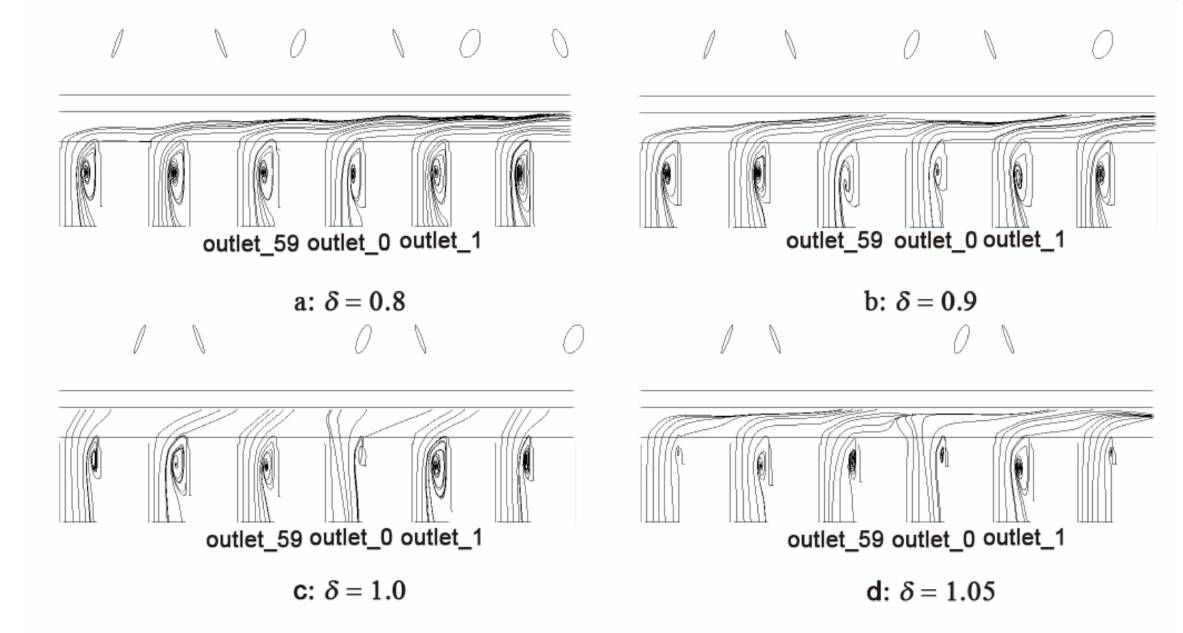
Figure 21. Streamlines at the cylindrical surface r* = 0.926 for different radius ratios of nozzles to holes: ( a ) δ = 0.8, ( b ) δ = 0.9, ( c ) δ = 1.0, ( d ) δ = 1.05.